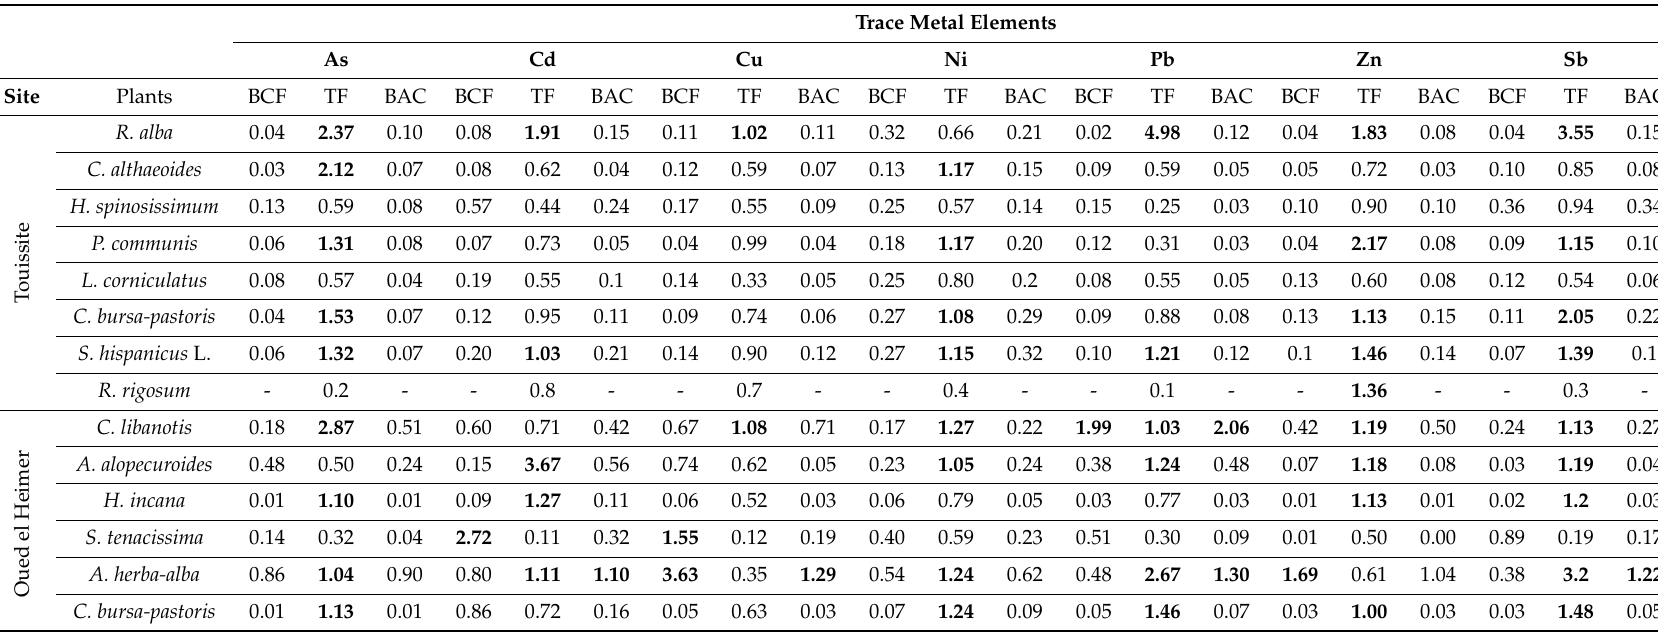
Bold values indicate BCF, TF and BAC values greater than